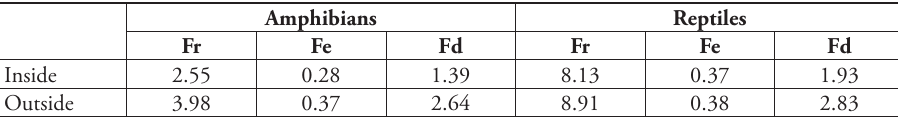
Figure 5. Graphic comparison of the number of species (total and by taxonomic group) inside and outside of Table 3. Functional richness (Fr), functional equity (Fe), and functional dispersion (Fd) of herpetofauna inside and outside of REBSSJ, Nayarit, Mexico.